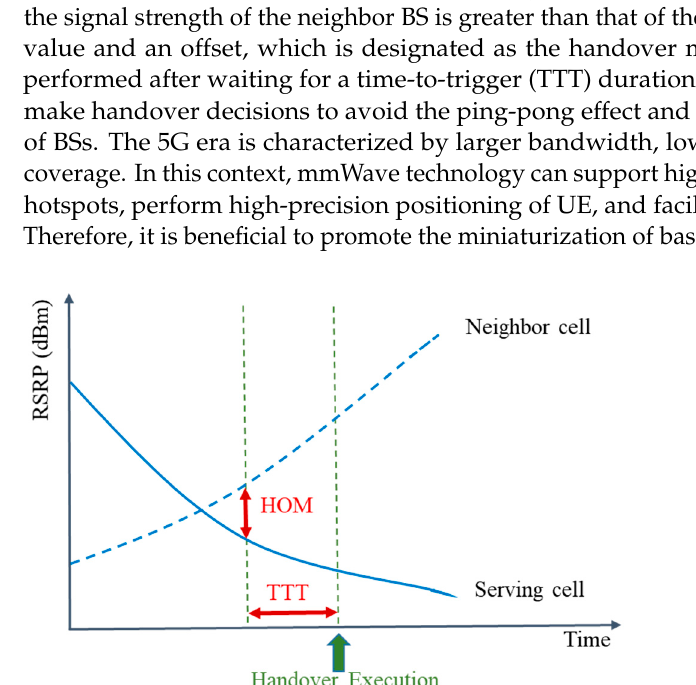
Figure 1. 5G UDN architecture.